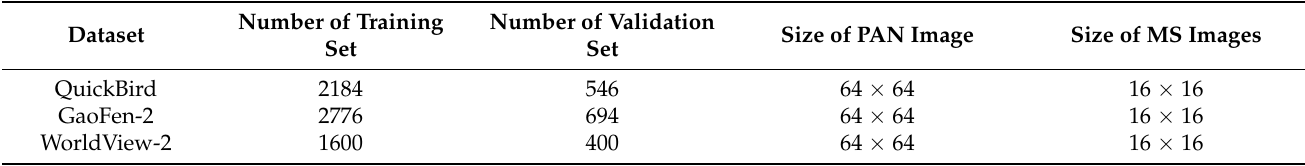
Table 2. Number of datasets and image sizes for QuickBird, GaoFen-2, and WorldView-2.